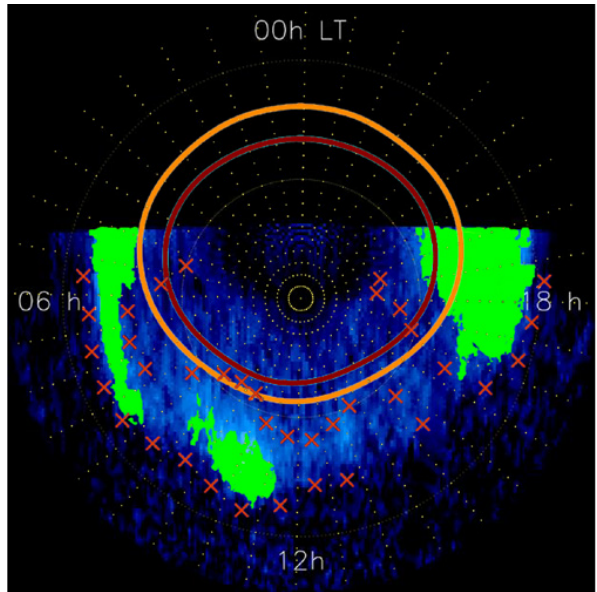
Fig. 9. HST UV southern auroral image C obtained at ∼ 07:10UT on day 45 of 2008 shown in the same format as Fig. 5. Bright emis- sion regions now are a dawn arc, near-noon spot, and a dusk